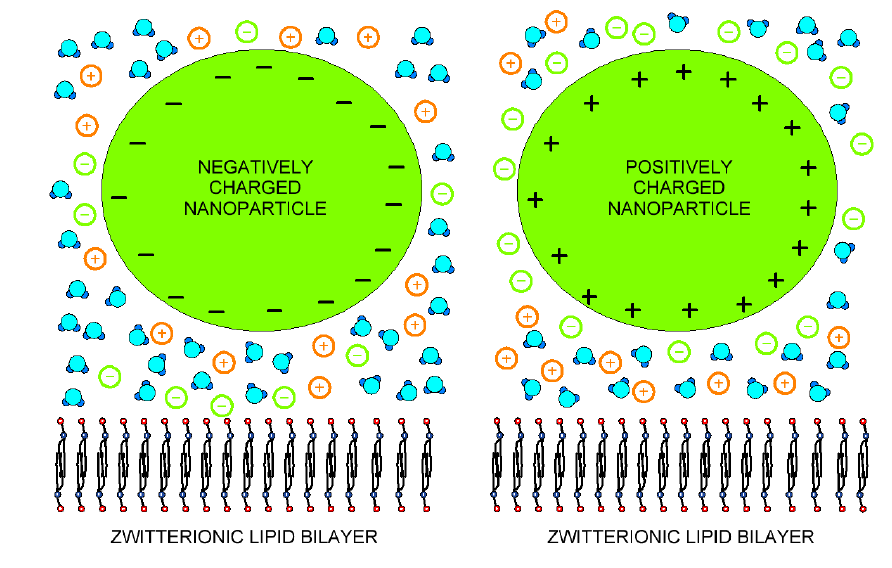
Figure 1. Schematic figure of dipolar zwitterionic lipid bilayer membrane in contact with the positively and negatively charged